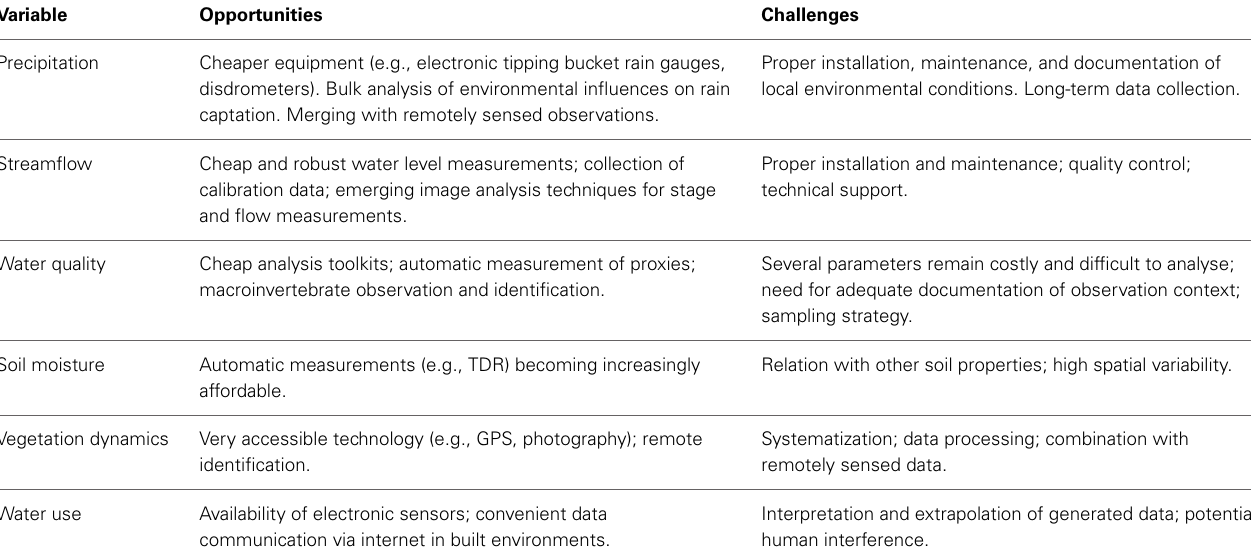
Table 2 | Commonly measured hydrological variables, and identified challenges and opportunities emerging from citizen science